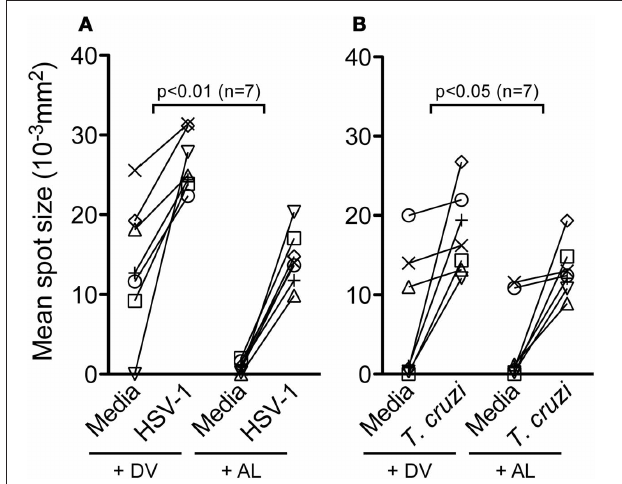
FIGURE 6 | Allopurinol decreases IFN- γ secretion at a single cell level. IFN- γ ELISPOT assays were performed by stimulation, or not (media), of PBMC from healthy donors with full viral particles from HSV-1 (A) , or PBMC from a group of chronically T. cruzi -infected subjects with a T. cruzi -derived amastigote lysate (B) , in the presence of allopurinol ( + AL, 300 μ g/ml) or drug vehicle ( + DV), for 18–20h. Mean spot sizes represent an estimate of IFN- γ production per cell. Each line represents an individual subject. Comparisons between T cell responses in the absence or presence of allopurinol upon stimulation were performed by Wilcoxon signed rank